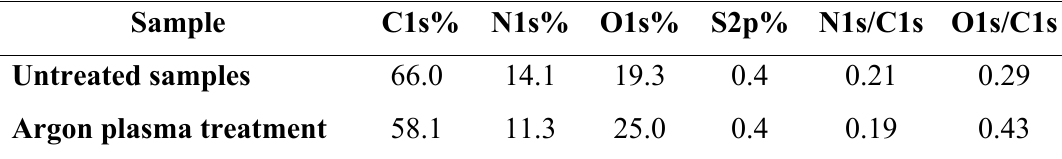
Table 1. Elemental compositions of the untreated and treated films by XPS measurement.